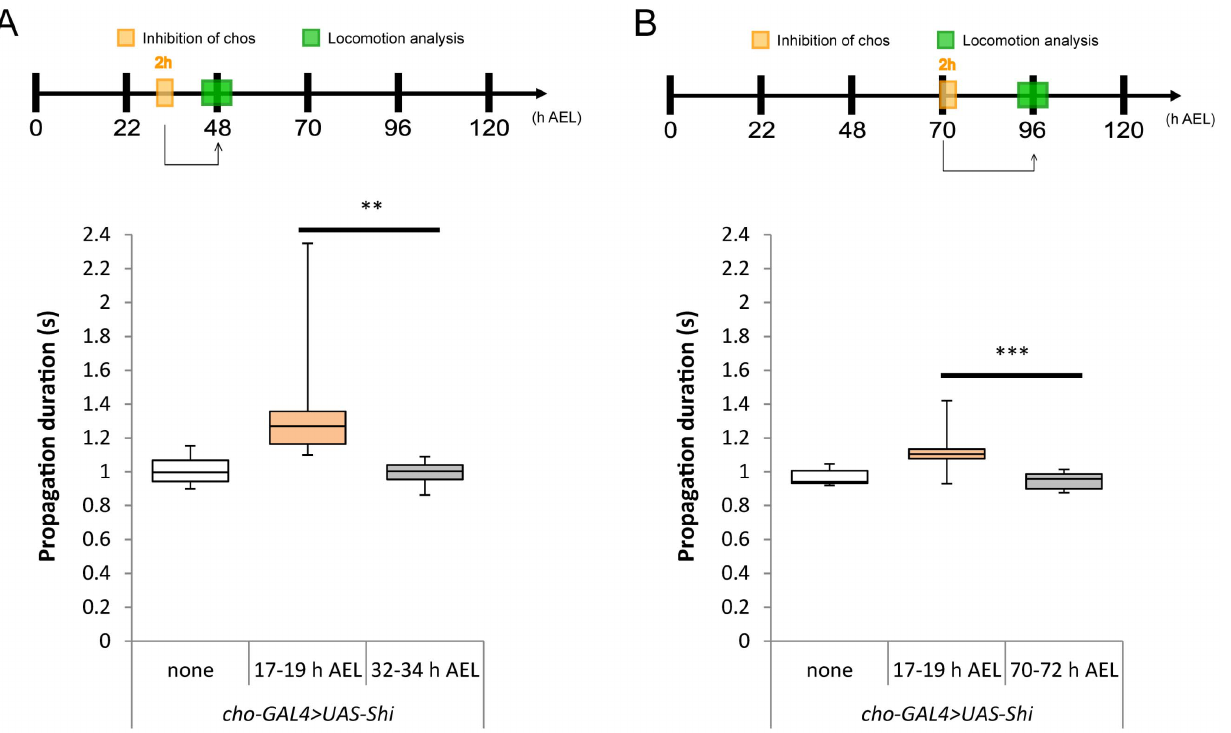
Figure 6. Inhibition of chordotonal organs at larval stage has no effect on the speed of larval locomotion. In contrast to the two-hour inhibition during the embryonic stage (17–19 h AEL), those during first (A, 32–34 h AEL) and third (B, 70–72 h AEL) instar stage had no effect on the speed of locomotion. Analyzed at second (A, 48 h AEL) and third instar (B, 96 h AEL) stages. Statistical significance was determined by one-way ANOVA followed by Tukey’s test for multiple comparisons (***P , 0.001; **P , 0.01). For all conditions, n=10. RT, restrictive